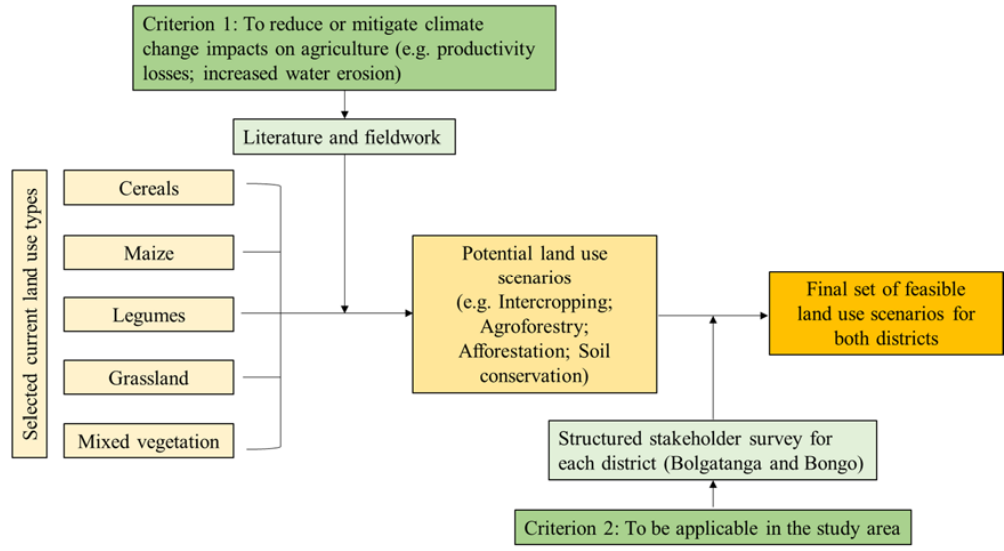
Figure 2. Development process of locally feasible land use scenarios.